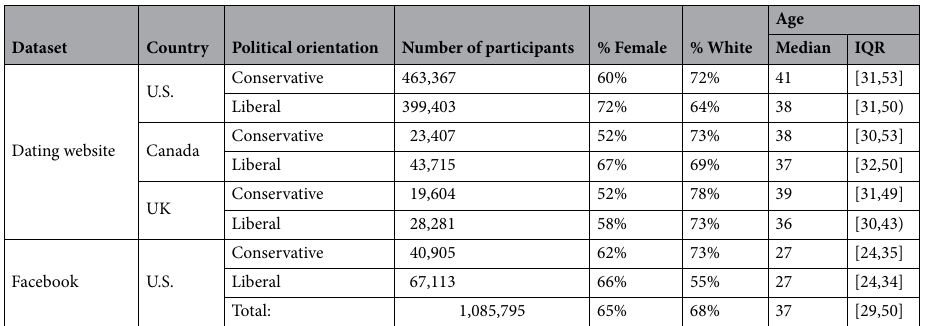
Table 1. Number of participants and the distribution of political orientation, gender, age, and ethnicity. IQR stands for interquartile range.